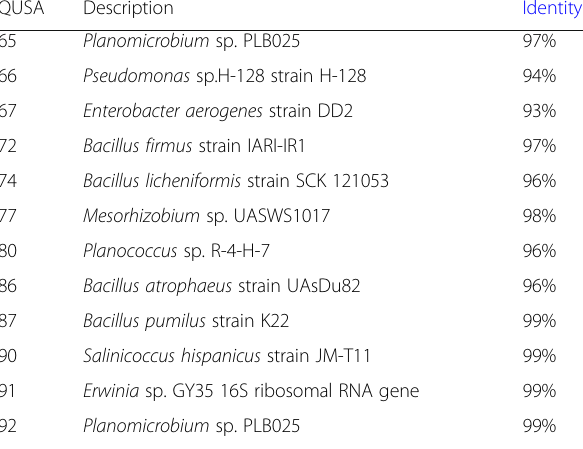
Table 3 Identification of bacterial isolates (QUSA) and their